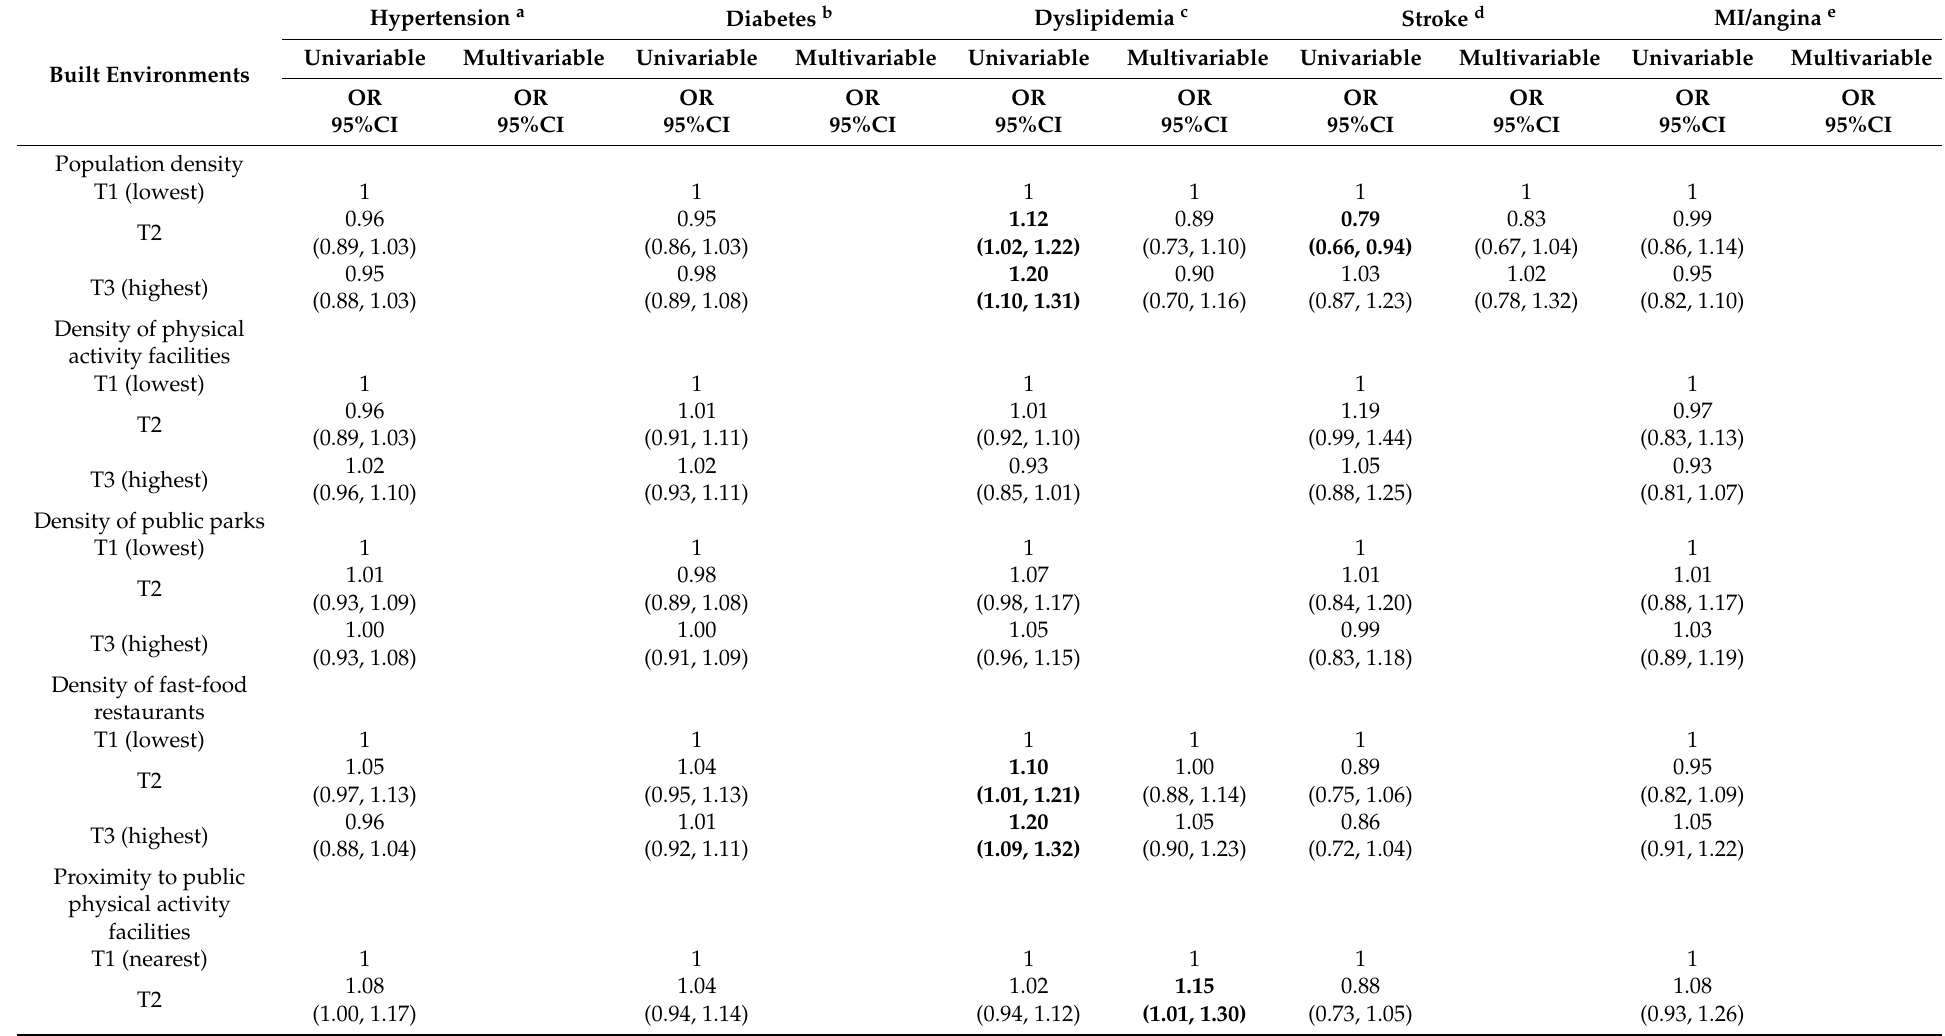
Table 4. Association between cardiovascular diseases and built environments in adults aged 60 years or